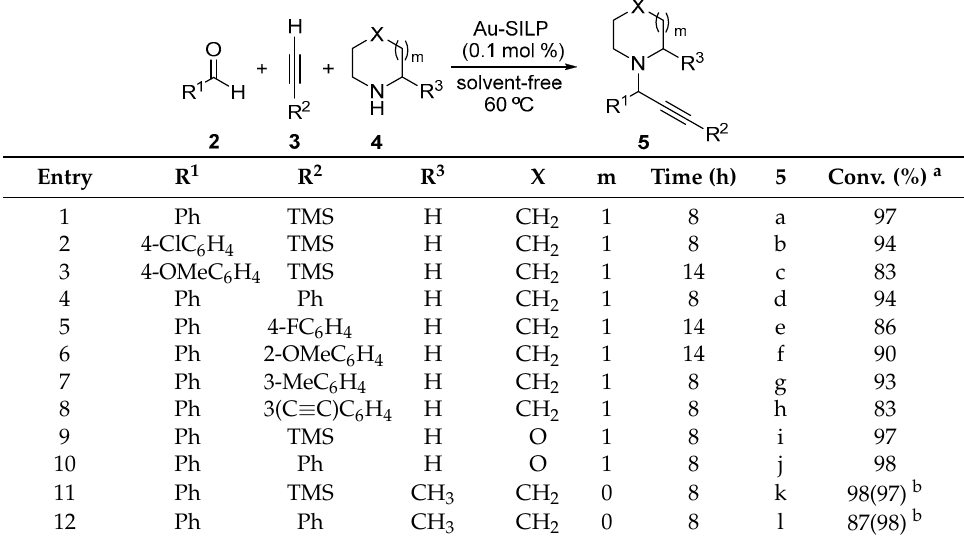
Table 3. Reusability of the Au–SILP